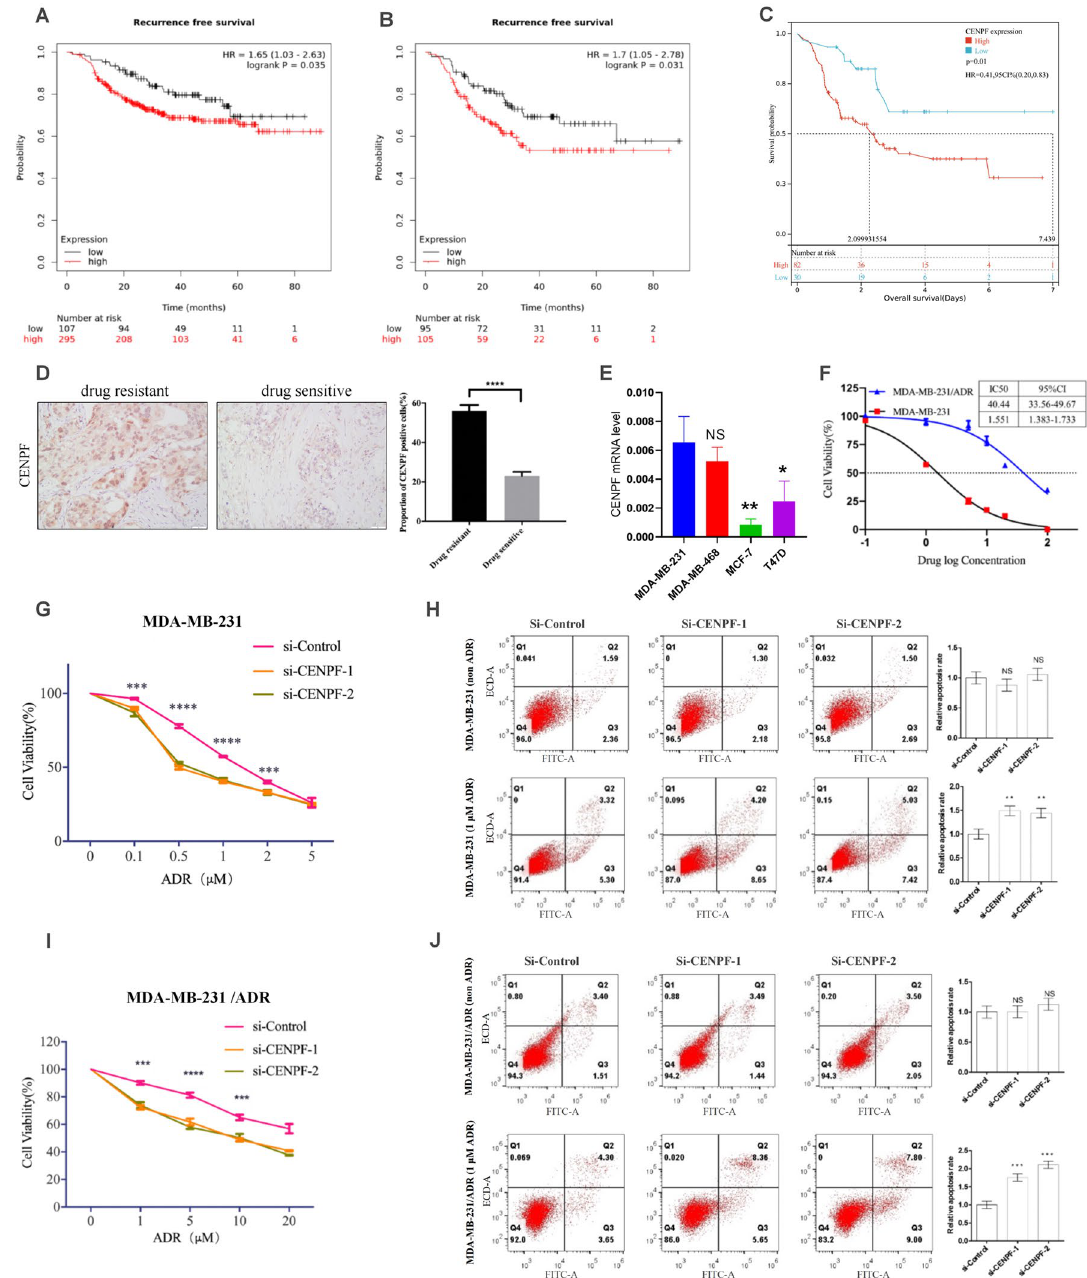
Figure 2. CENPF increases the ADR chemosensitivity of TNBC. ( A,B ) Recurrence-free survival in breast cancer patients receiving NACT ( A , n = 403, log-rank P = 0.035) or TNBC treatment with NACT ( B , n = 200, log- rank P = 0.031), using Kaplan ‒ Meier Plotter. ( C ) Overall survival in TNBC patients receiving NACT ( C , n = 112, P = 0.02). Data were obtained from GSE25066. ( D ) Quantification of IHC staining for CENPF chemo-resistant and chemotherapy-sensitive TNBC. ( E ) CENPF mRNA quantification in MDA-MB-231, MDA-MB-468, MCF-7 and T47D cells performed by RT ‒ qPCR. F IC50 of adriamycin in MDA-MB-231 and MDA-MB-231/ADR cells. ( G – J ) We used a drug sensitivity assay to assess the effects of CENPF knockdown on ADR chemosensitivity in MDA-MB-231 ( G ) and MDA-MB-231/ADR ( I ) cells. We performed an Annexin V-FITC/PI apoptosis assay to investigate the role of CENPF in cell apoptosis with or without adriamycin in MDA-MB-231 (H) and MDA-MB-231/ADR ( J ) cells. Data shown represent the means (± SD) of three independent